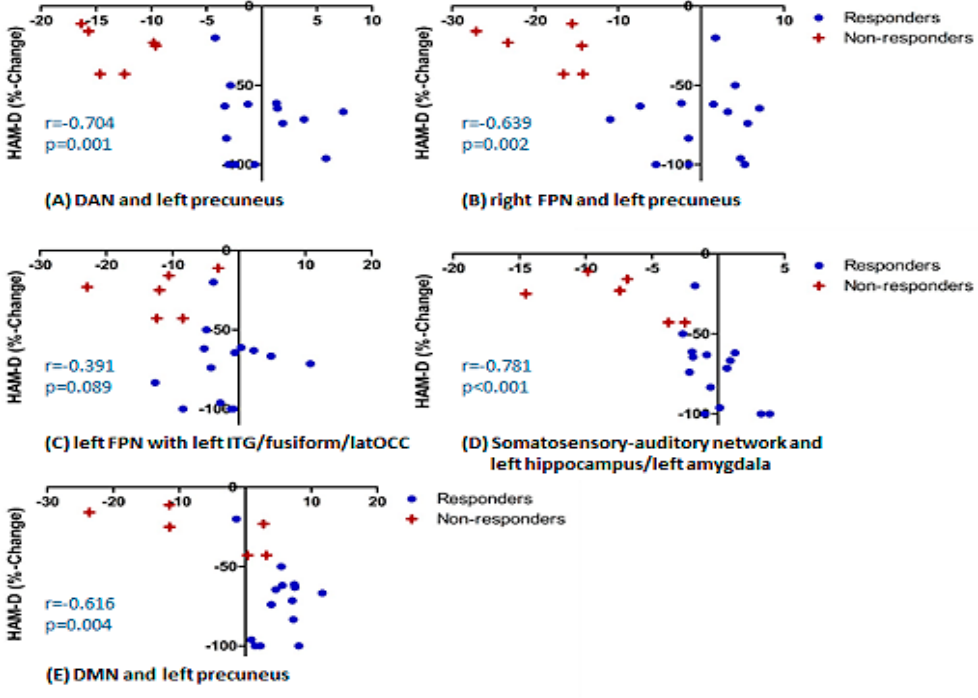
Figure 3. Correlations between established connectivity measures and % change in HAMD scores. DAN-dorsal attention network; FPN-fronto-parietal network; DMN-de- fault mode network; ITG-inferior temporal gyrus; latOCC-lateral occipital